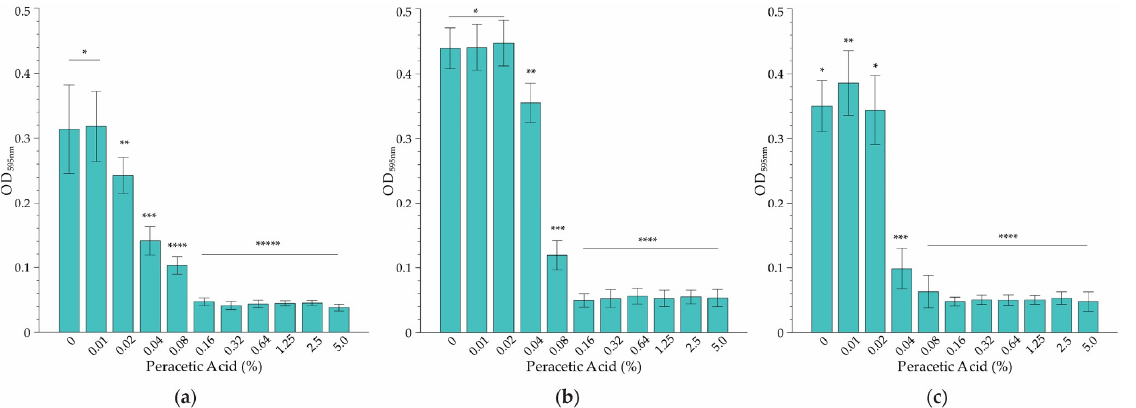
Figure 2. The minimum concentration of PAA sanitizer that inhibits growth (MIC) of L. monocytogenes serovar 1 / 2 a EGD-e as determined at ( a ) 10 ◦ C, ( b ) 22 ◦ C and ( c ) 37 ◦ C using the broth dilution assay. Each bar represents the average of three replicates of three independent experiments, and error bars indicate the standard deviation ( n = 9). Significance differences between concentrations at each temperature are indicated by *, **, ***, **** and ***** respectively as determined by ANOVA ( p > 0.05).